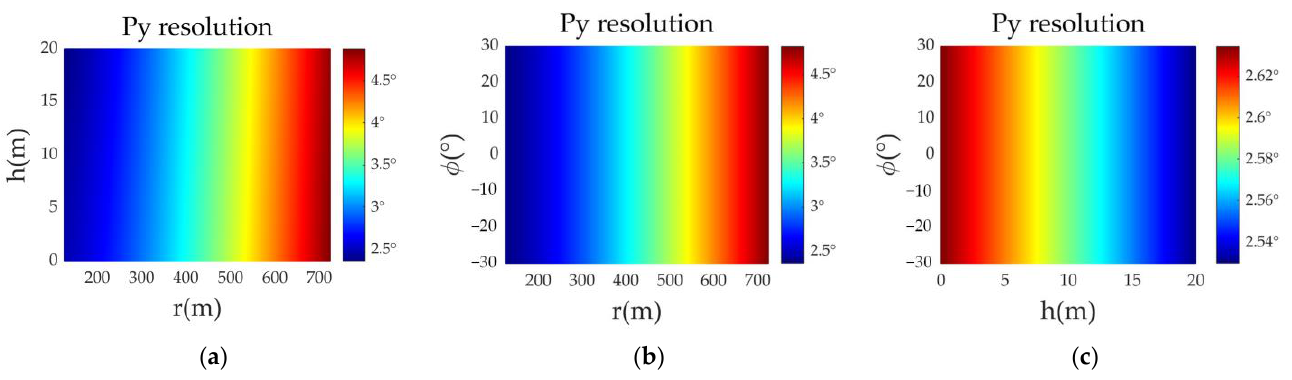
Figure 5. Azimuth resolution of targets at different positions. ( a ) The target azimuth angle is 30°; ( b ) the target height is 10 m; ( c ) the target distance is 200 m.